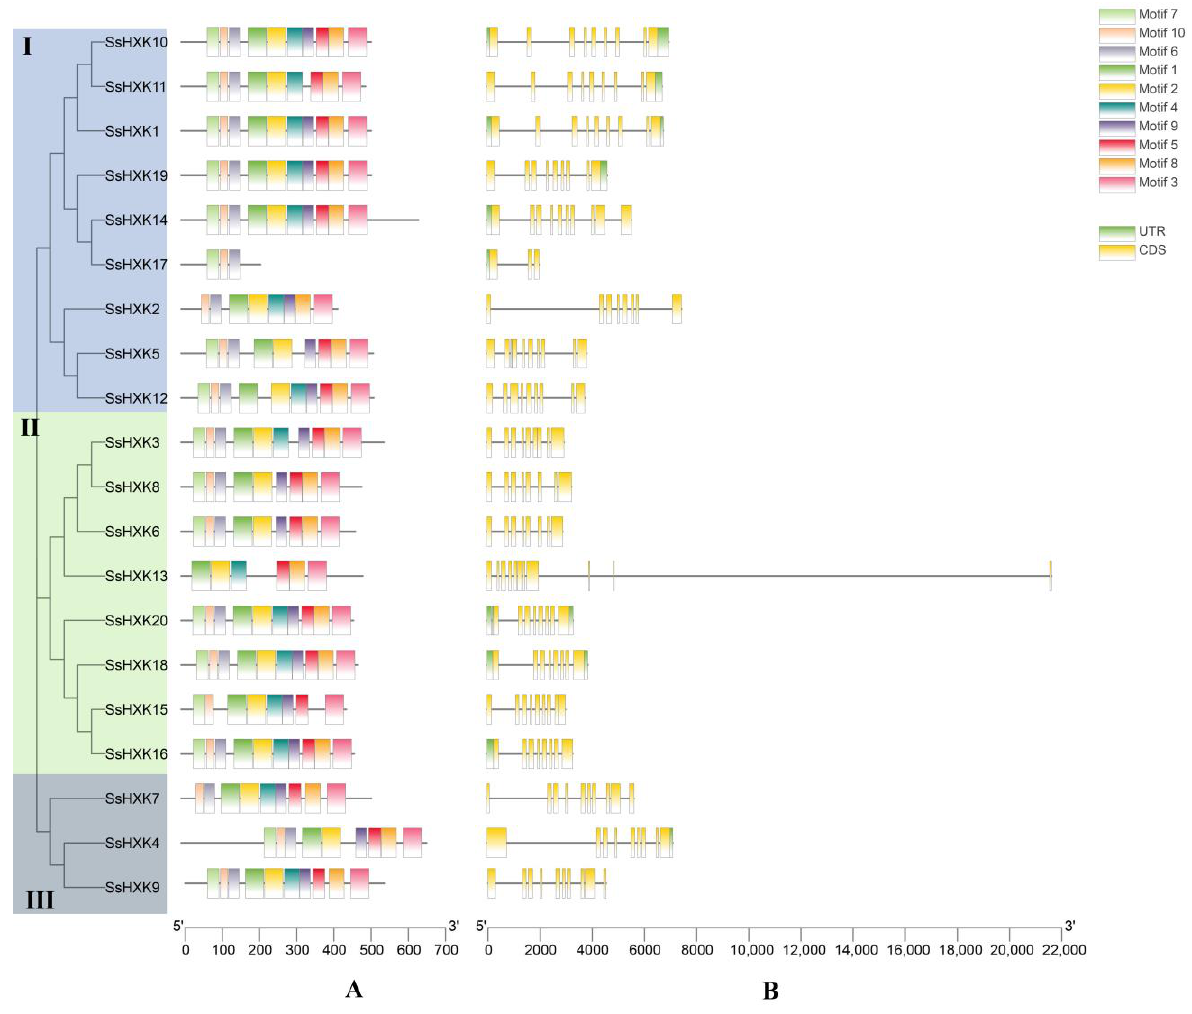
Figure 5. Phylogenetic tree, conserved motif, and the gene structure of the HXK genes. The phylogenetic tree was constructed using MEGA X software based on HXK protein sequences: ( A ) conserved motifs of the HXK proteins. Each motif is represented with a specific color; and ( B ) gene structure of HXK gene. The untranslated 5′ - and 3′ -regions, introns and exons are represented with green boxes, yellow boxes, and black lines, respectively.